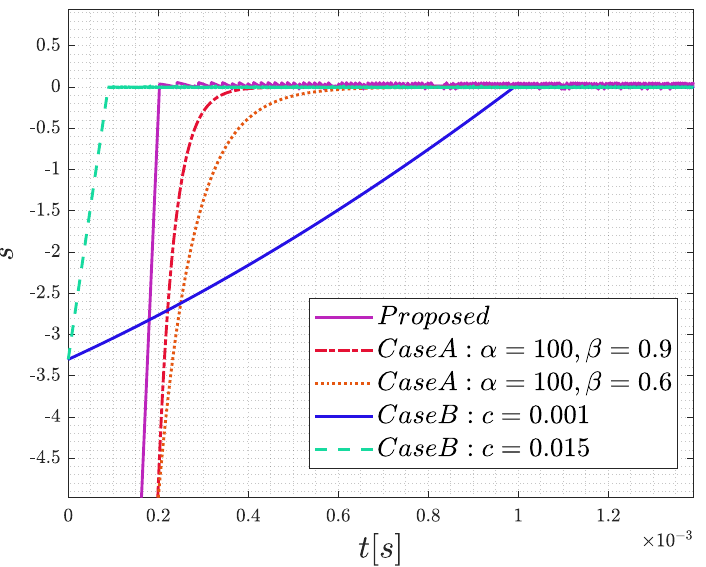
Figure 3. Finite-time convergence of the sliding surfaces to the output variable for the cases given in Section